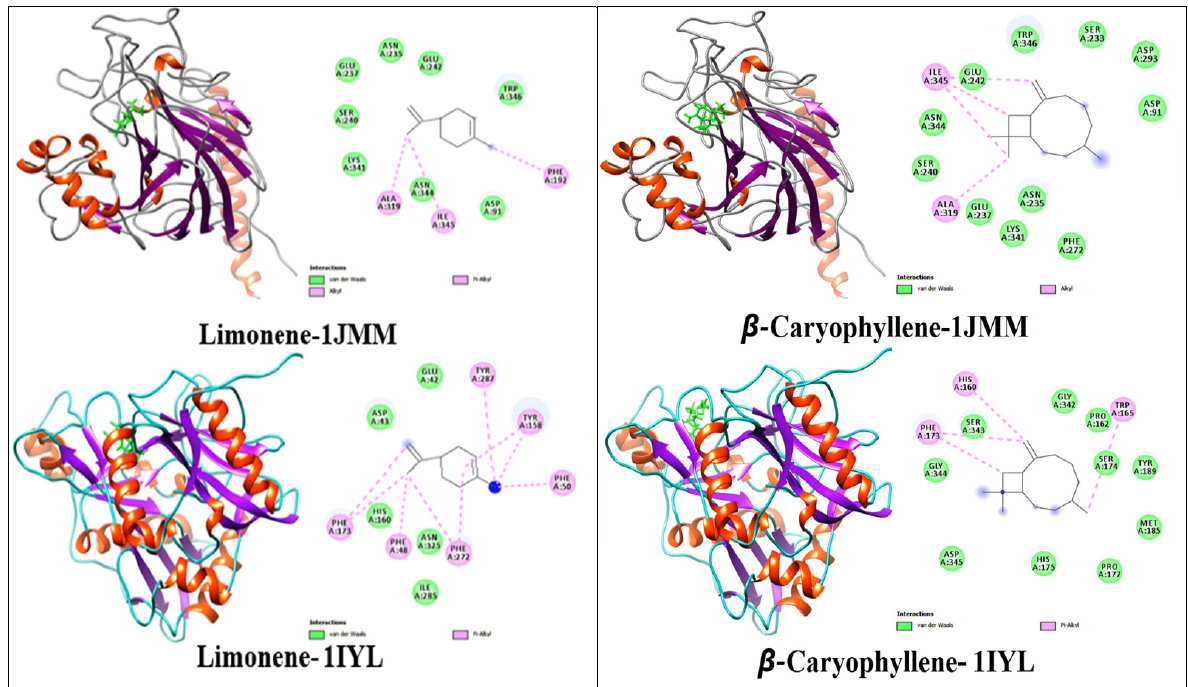
Figure 4. Interaction of the 1JMM and 1IYL protein with the ligand D-limonene and β -caryophyllene. S. mutans receptor 1JMM and Candida receptor 1IYL showed a binding energy of 7.42 and − 7.39 kcal/mol against limonene and β -caryophyllene, respectively. A similar trend in linkage values was observed for both limonene and β -caryophyllene. The Ki range of limonene and β -caryophyllene was highest against the Candida target 1IYL (640.45 µ M) and moderate against the S. mutans target (752.10 µ M). The Ki value against the S. mutans target (1JMM) was lower than against